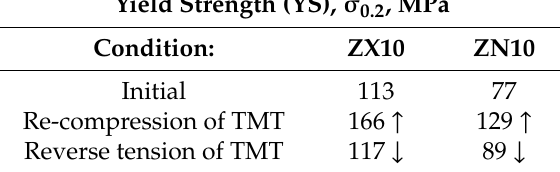
Figure 2. Engineering stress vs. plastic strain dependence for alloys in an as-extruded state ( a ) and in the thermo-mechanically treated (TMT) state: ( b ) ZX10-pre-compression up to 140 MPa (3% of strain) and isothermal aging at 150 °C for 16 h; ( c ) ZN10-pre-compression up to 120 MPa (3% of strain) and isothermal aging at 150 °C for 48 h. Please note that subfigures ( b , c ) represent the enlarged region of yielding. Black line in ( b , c ) refers to the pre-compression level for each alloy. Table 1. Values of yield strength (YS), σ 0.2, for ZX10 and ZN10 alloys in as-extruded and in the TMT state. Symbols ↓ and ↑ represent a decrease or increase of CYS and TYS values with respect to pre-compression level (140 MPa for ZX10, 120 MPa for ZN10), i.e., softening or hardening, respectively. YS ± 1 MPa.